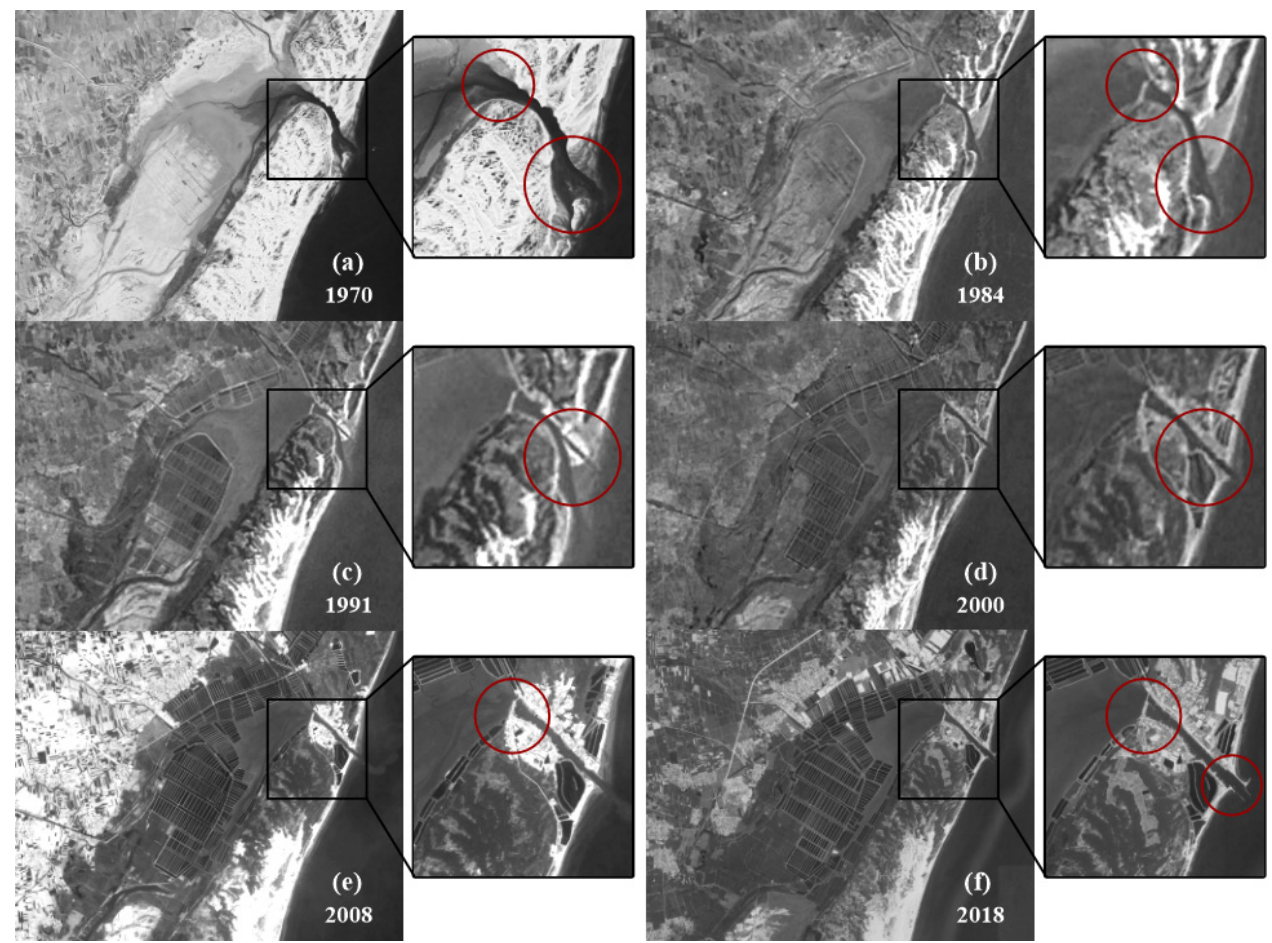
Figure 2. Satellite images of QL in 1970 ( a ), 1984 ( b ), 1991 ( c ), 2000 ( d ), 2008 ( e ) and 2018 ( f ). The red circles highlight the hotspots of geomorphological changes.